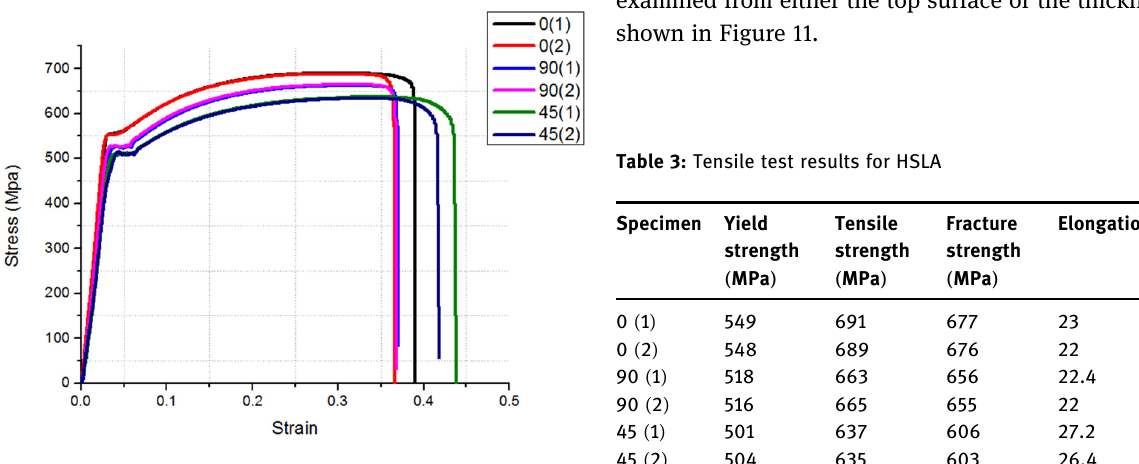
Figure 12: Stress – strain curve for